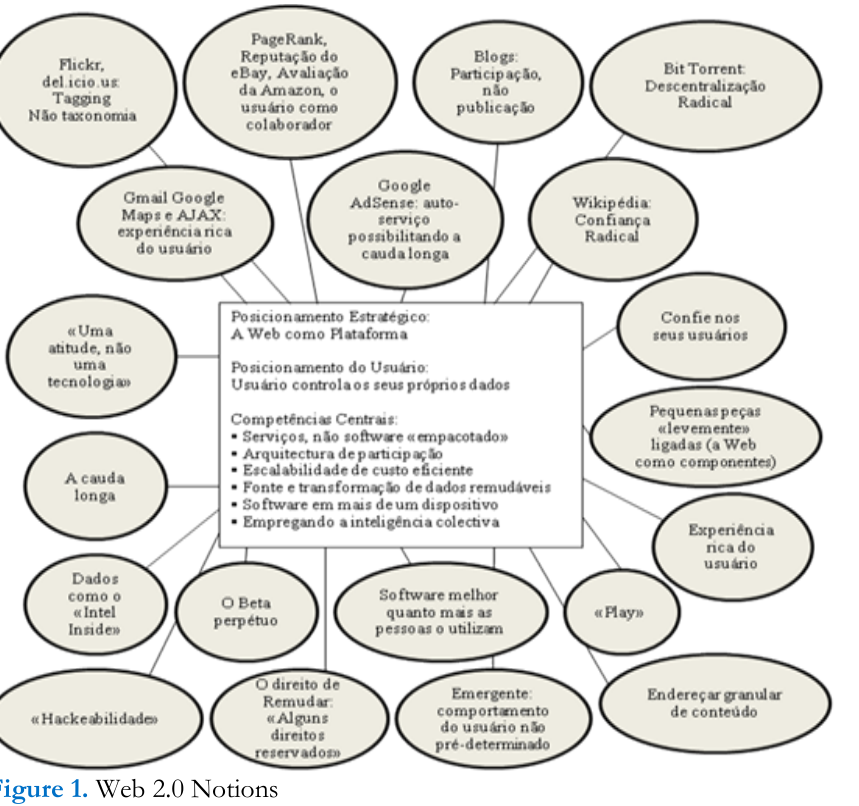
Figure 1. Web 2.0